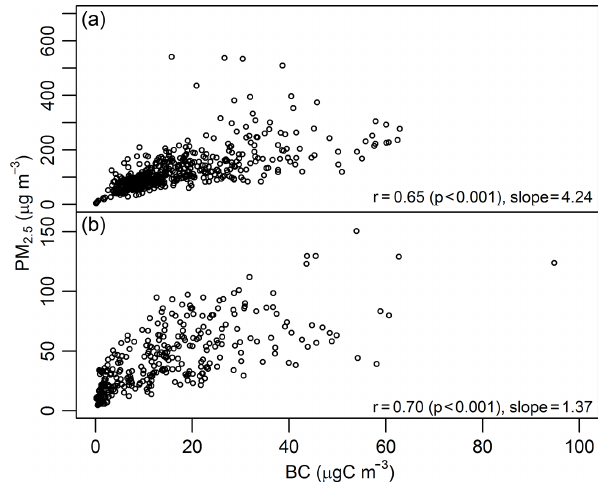
Figure 5. Correlation between PM 2 . 5 concentrations and BC con- centrations observed at six near-road sites in the Kathmandu Valley over the sampling periods in the (a) spring season and (b) monsoon season in